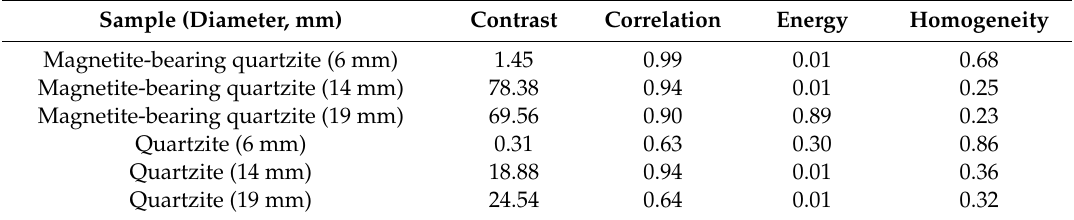
Table 4. Statistical descriptors which accompanies each of the 3D GLCM heat maps presented for the magnetite-bearing quartzite and quartzite. Results are given for individual 2D images slices for three di ff erent drill core sizes (6, 14 and 19 mm). Note the GLCM statistical descriptors are unitless. Sample (Diameter, mm) Contrast Correlation Energy Homogeneity Magnetite-bearing quartzite (6 mm)